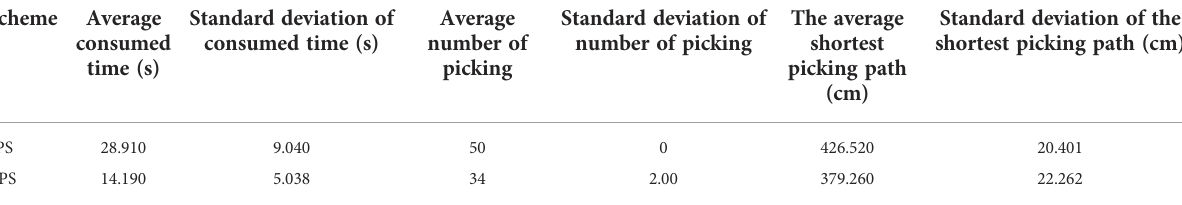
TABLE 3 Comparison of 100 experimental statistical results of the two picking schemes. Scheme